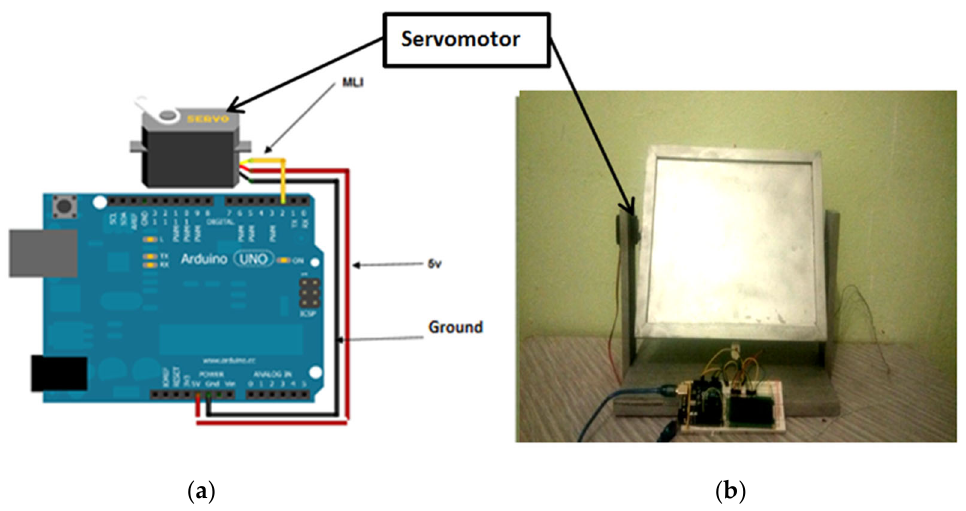
Figure 3. ( a ) Servo motor electrical diagram; ( b ) Position of the servo motor compared with the Arduino card. Table 1. Characteristic parameters of the servomotor used in the construction of the prototype of the single ‐ axis tracker.